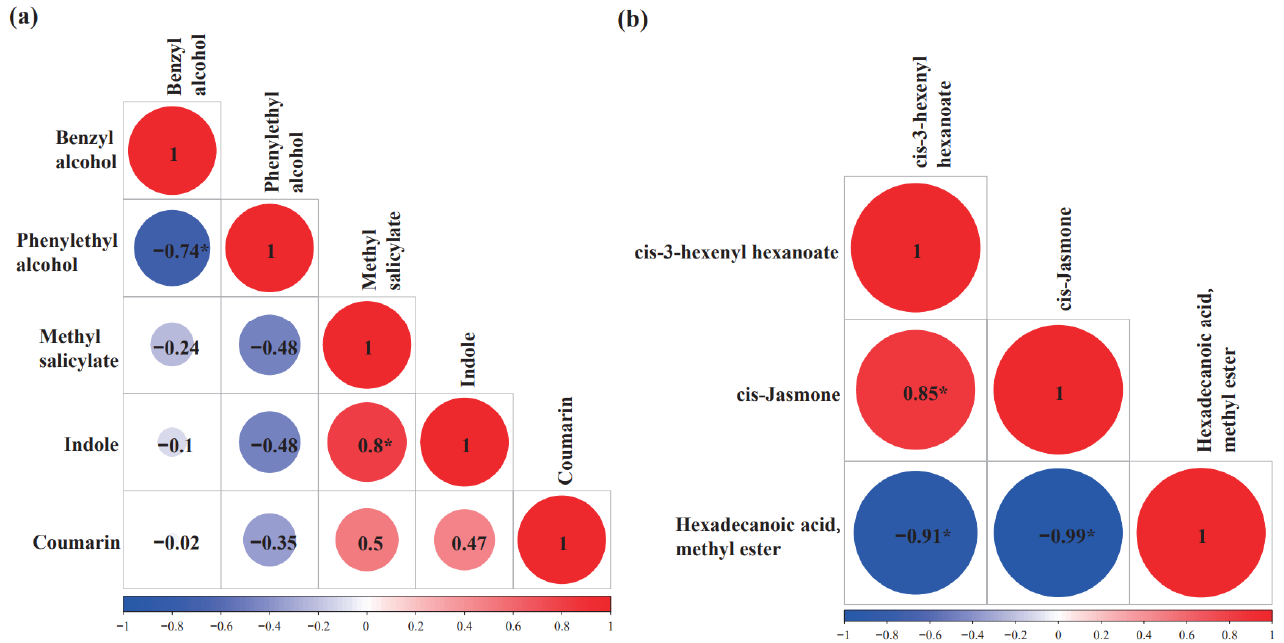
Figure 6. Correlations among the volatiles derived from the shikimate–phenylpropanoid pathway ( a ) and the fatty acid-derivative pathway ( b ). Asterisk represent statistically significant. Among the fatty acid-derivative volatiles, hexadecenoic acid methyl ester was neg- atively correlated with cis -3-hexenyl hexanoate (R = − 0.91) and cis -jasmone (R = −